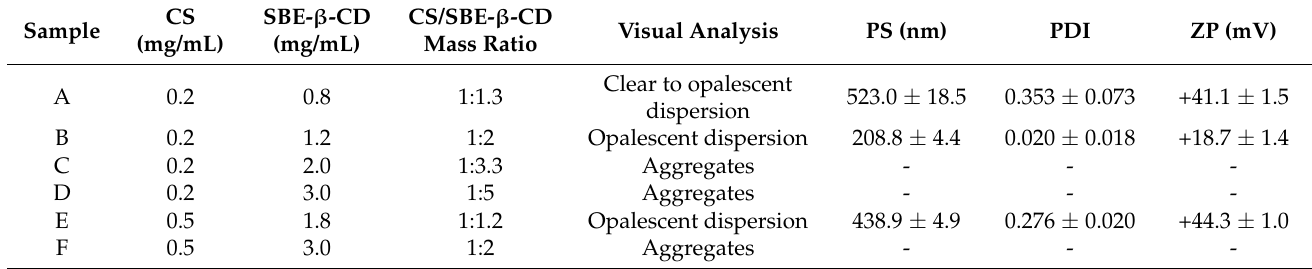
Table 2. Formulation parameters and visual analysis results of initial screening tests.